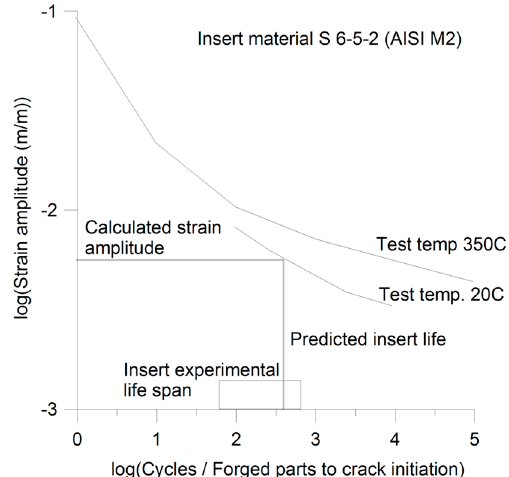
Figure 5. Illustration of the outcome of a local strain approach for damage analysis ref. [2].